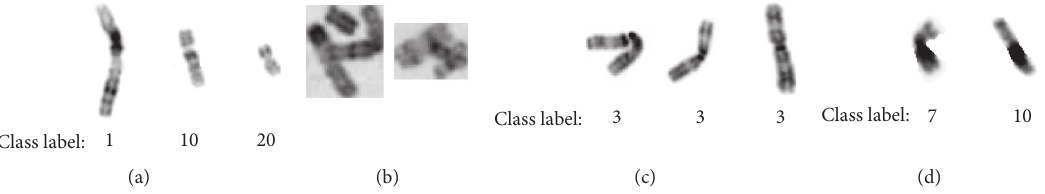
Figure 1: Challenges for chromosome karyotyping: (a) total 24 classes for classification (including 22 pairs of autosomes and 2 sex chromosomes XY), (b) occluding and touching chromosomes, (c) unpredictable shape with curving, and (d) local intensity varieties and unclear shape boundary.